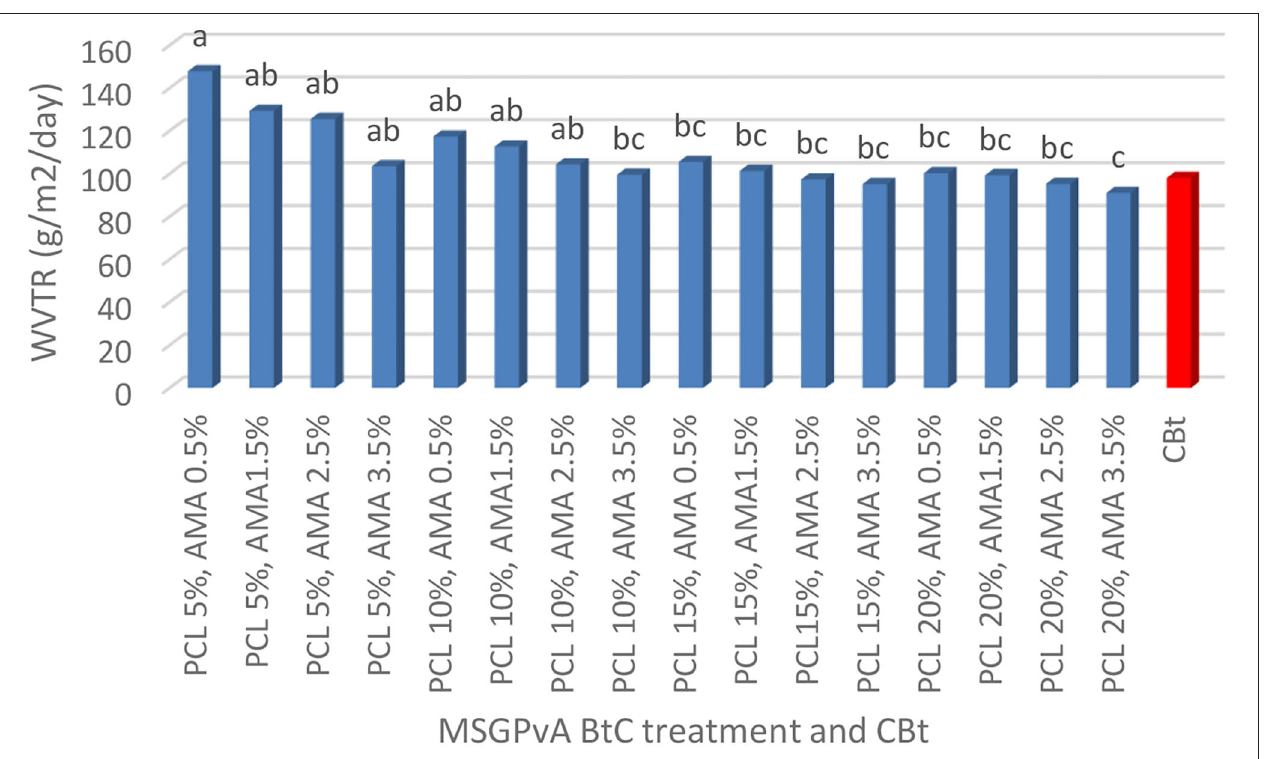
FIGURE 5 | Relationship of MSGPvA BtC and CBt with